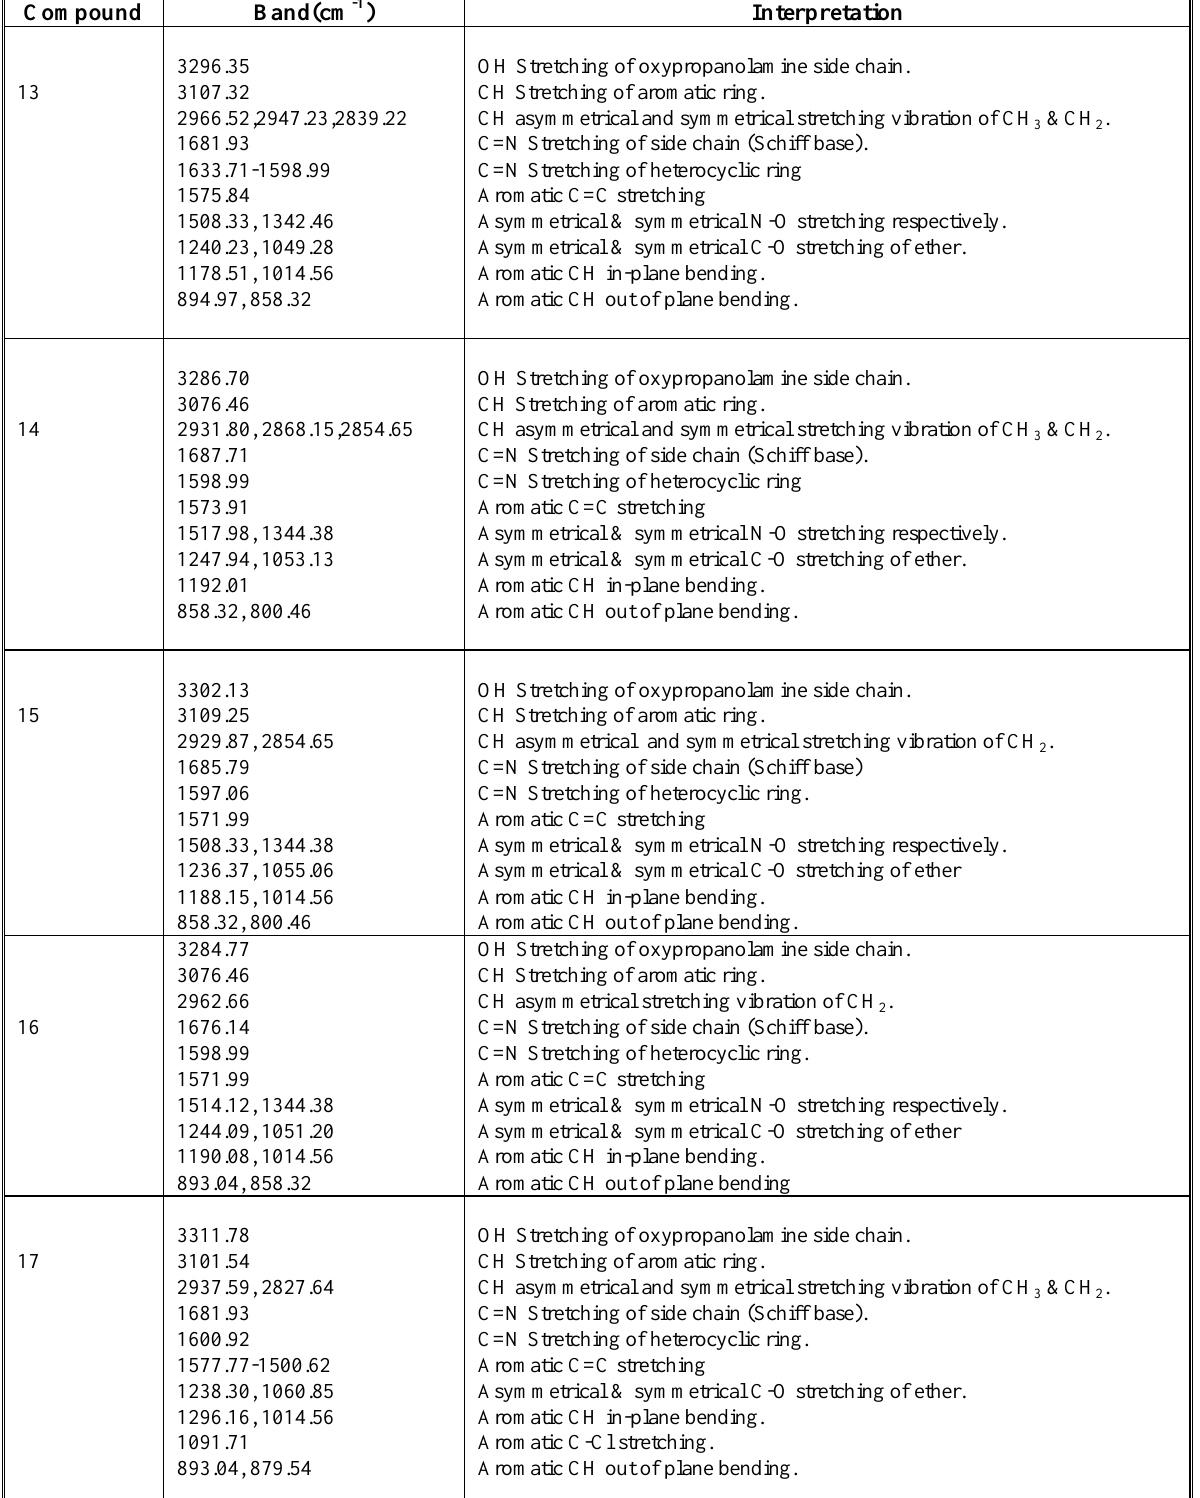
Table (4): Characteristic IR absorption of the final compounds